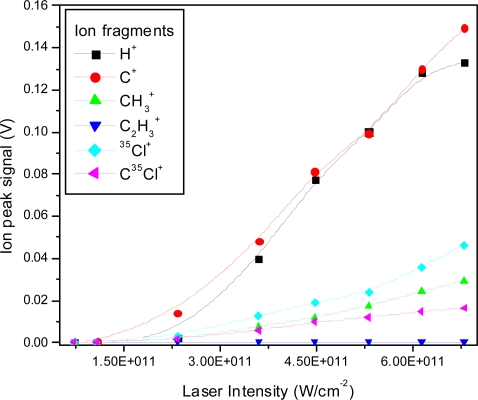
Ion peak signals as a function of laser intensity for H+, C+, CH3+, C2H3+, 35Cl+, C35Cl+ fragment ions using 355 nm laser radiation with 8 ns pulse duration.